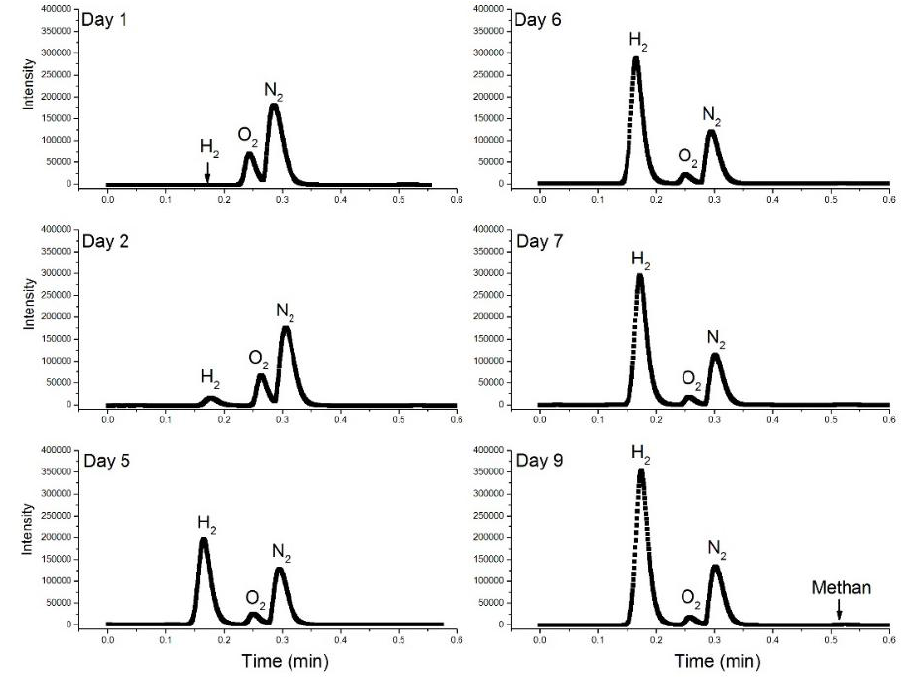
, O and N . Figure 6. GC-TCD profiles during the incubation time – Changes in H 2 2 2 2 , O 2 and N 2